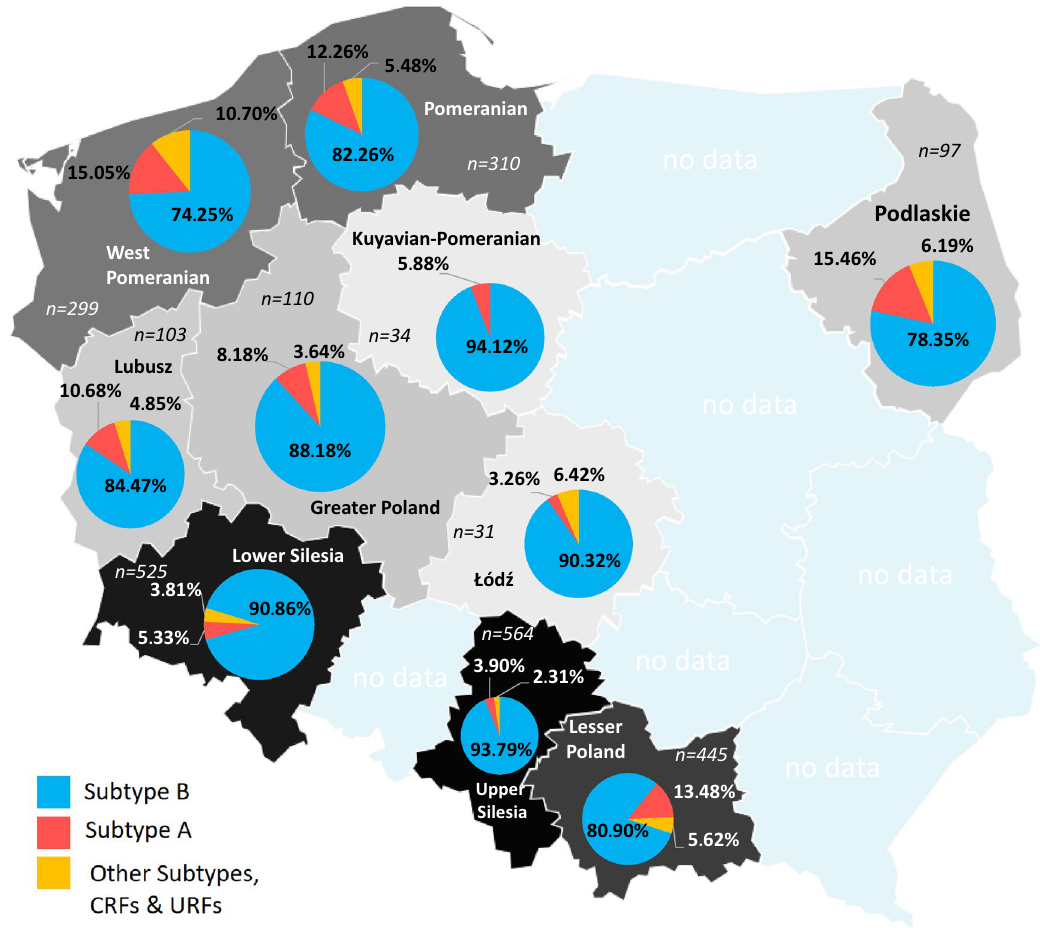
Figure 4. Distribution of subtype B, subtype A and all non-B, and non-A variants across analysed